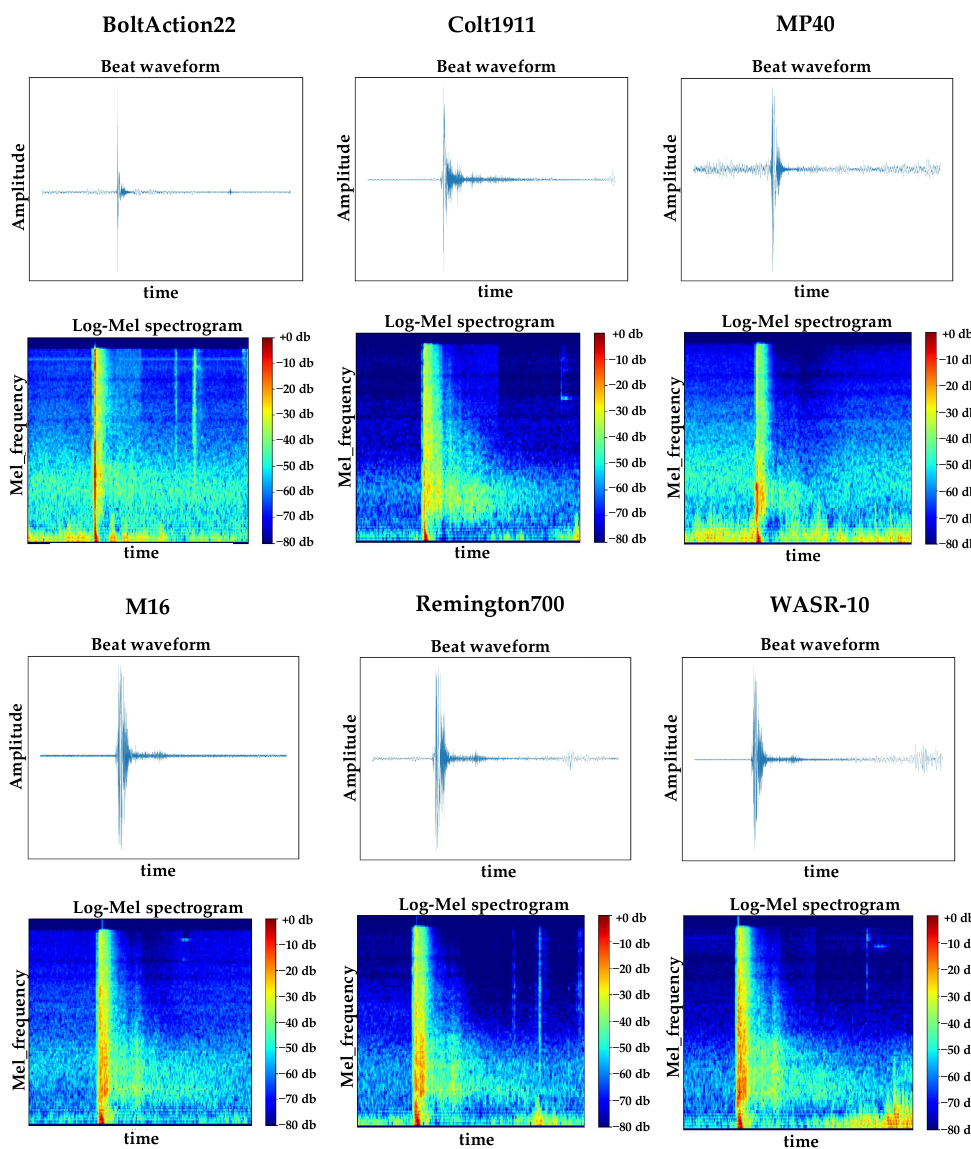
Figure 8. Waveform and Log-Mel spectrogram of the sound sample.